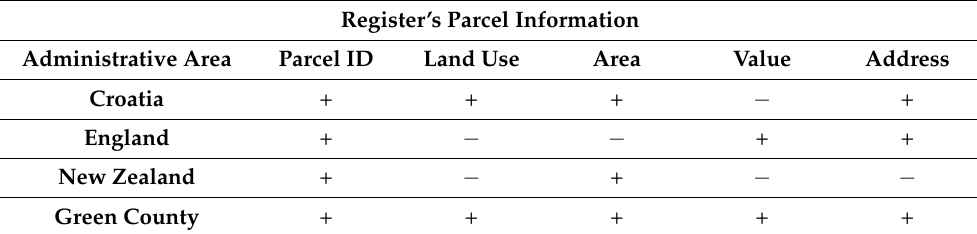
Table 2. Attribute analysis of Register’s information on parcels.